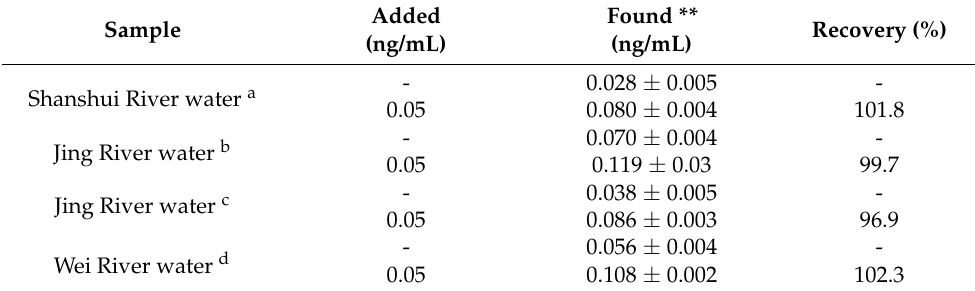
Table 4. Determination results of cobalt in environmental water